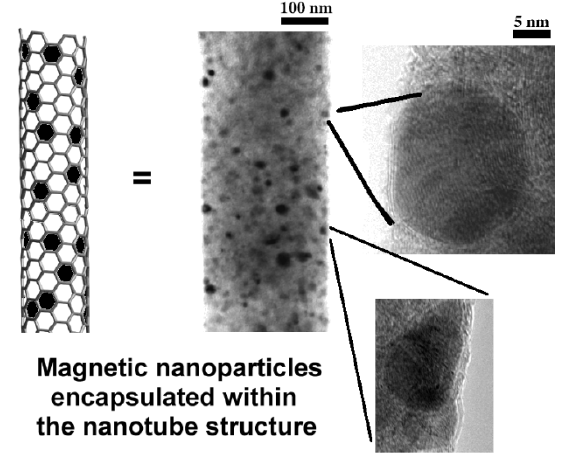
Figure 14. Schematic representation of magnetic nanoparticles encapsulated within the graphitic wall of CNTs and transmission electron microscopy of magnetic